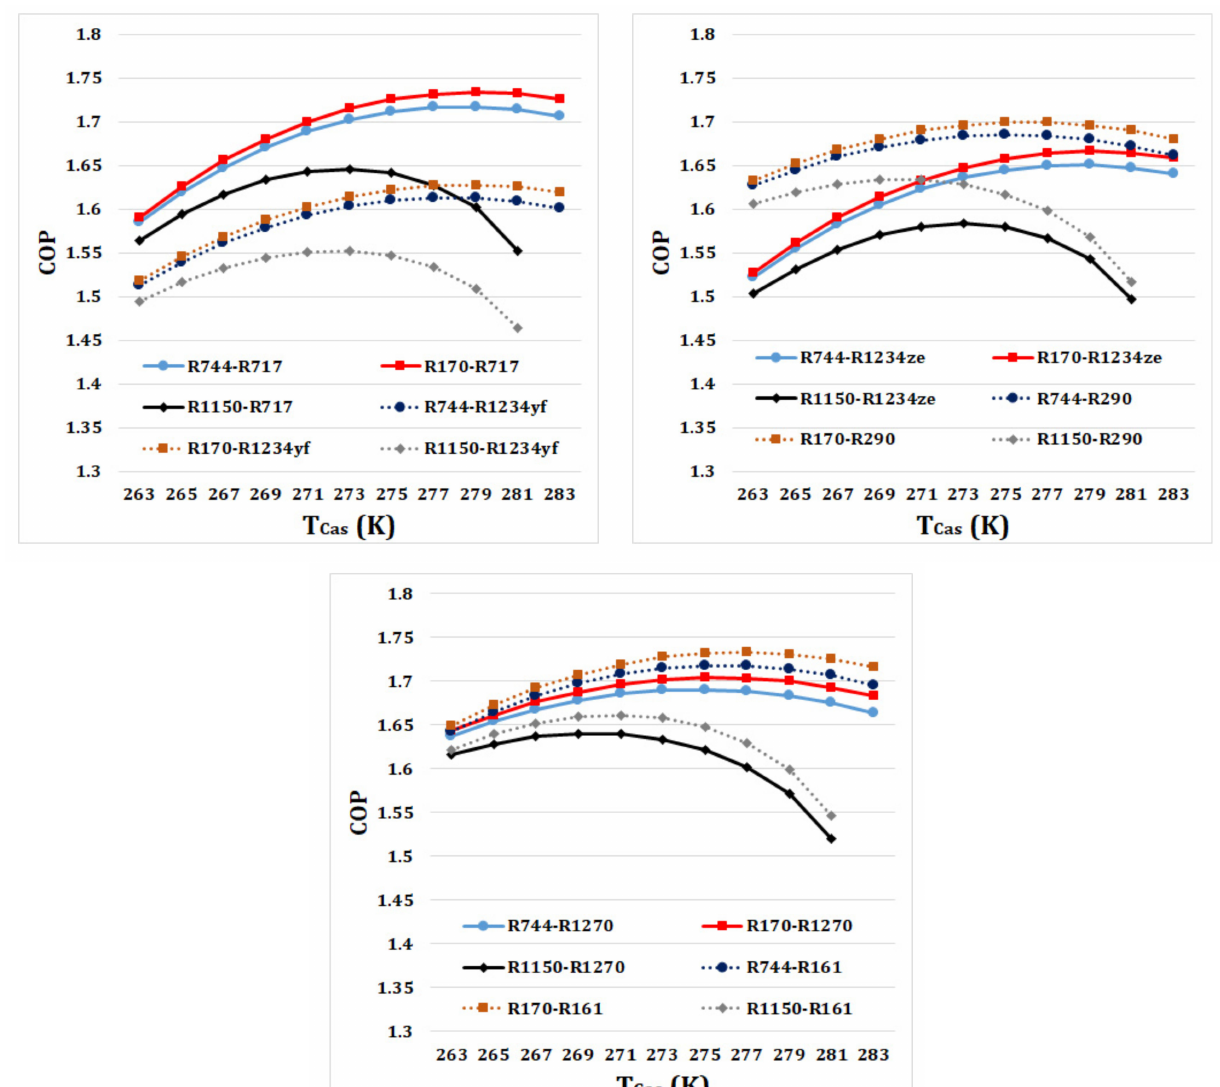
Figure 4. Effect of temperature of the cascade heat exchanger ( T Cas ) on the COP for different refrigerant